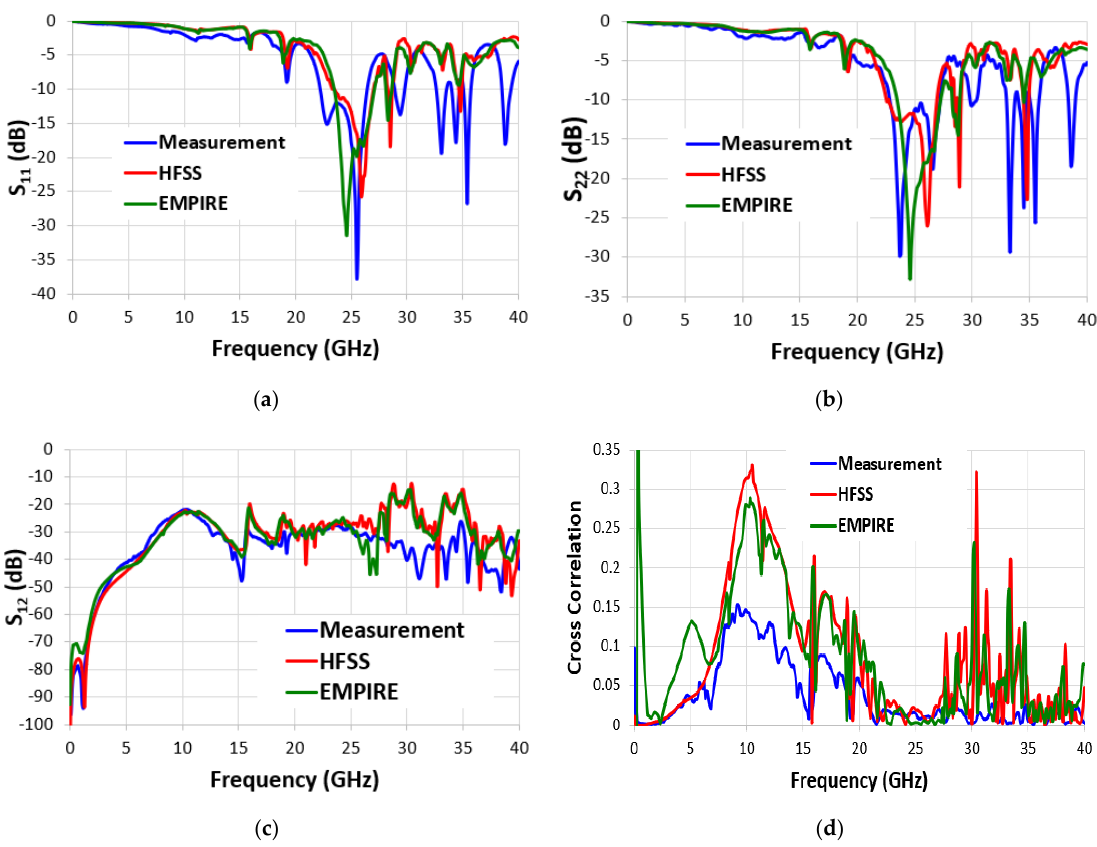
Figure 3. Broadband measurement of return-losses S11 ( a ), S22 ( b ) and near-coupling S12 ( c ) of the antenna elements compared to 3D full-wave simulations. Measured correlation functions ( d ) versus 3D full-wave simulations as function of frequency.